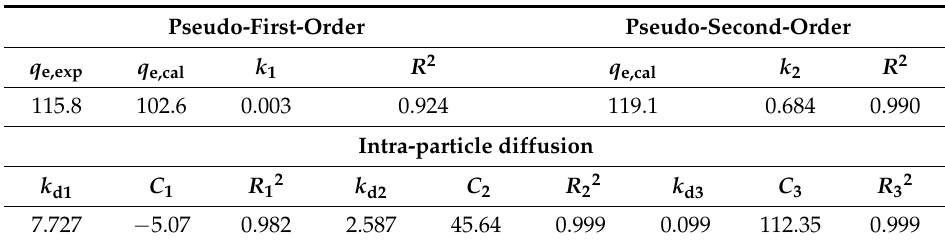
Table 2. Kinetic model fitting